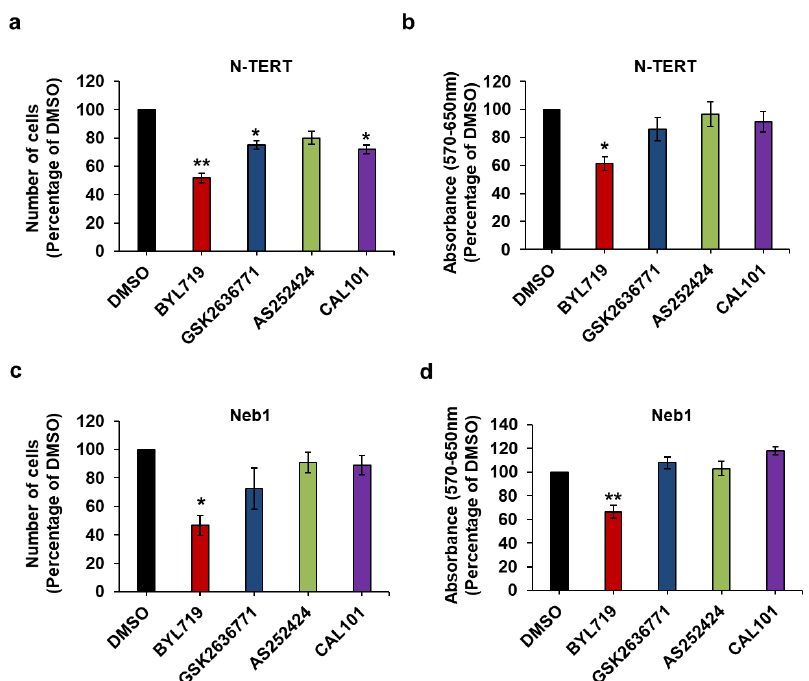
Figure 4. The p110 α inhibitor BYL719 is the most effective in reducing both cell numbers and viability of keratinocytes. N-TERT ( a , b ) and Neb1 ( c , d ) cells were treated with 1 µM of the indicated inhibitors or vehicle (DMSO) in complete medium supplemented with 10% FBS. After 72 h, number of cells was assessed by cell counting ( a , c ) and cell viability was assessed by MTT assays ( b , d ). Data are expressed as percentage of results from cells treated with DMSO and are means ± SEM from n = 3 ( a ), n = 3 ( b ), n = 3 ( c ) and n = 4 ( d ) independent experiments performed in duplicate ( a , c ) or triplicate ( b , d ). * p < 0.05, ** p < 0.01 vs. DMSO.